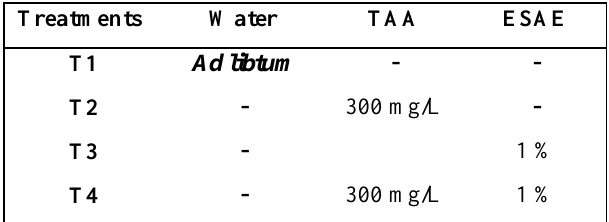
Table 1: Experimental